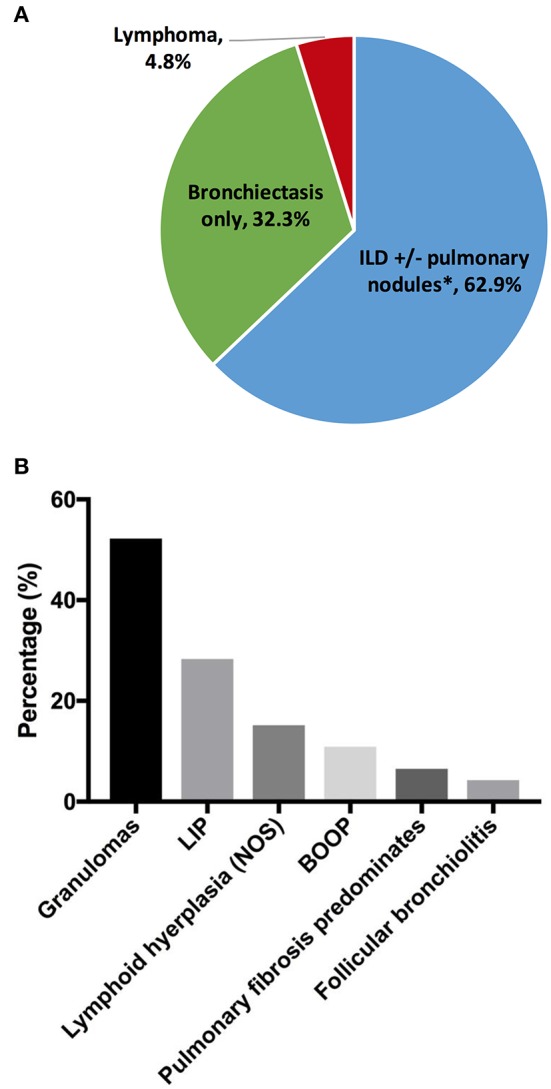
Chronic lung disease. (A) Lung disease types by radiographs and/or pathology reports (n = 124). (B) Interstitial lung disease pathologies (n = 46). *Thirteen out of 65 subjects with ILD had concurrent bronchiectasis. ILD, interstitial lung disease; LIP, lymphoid interstitial pneumonia; BOOP, bronchiolitis obliterans organizing pneumonia.